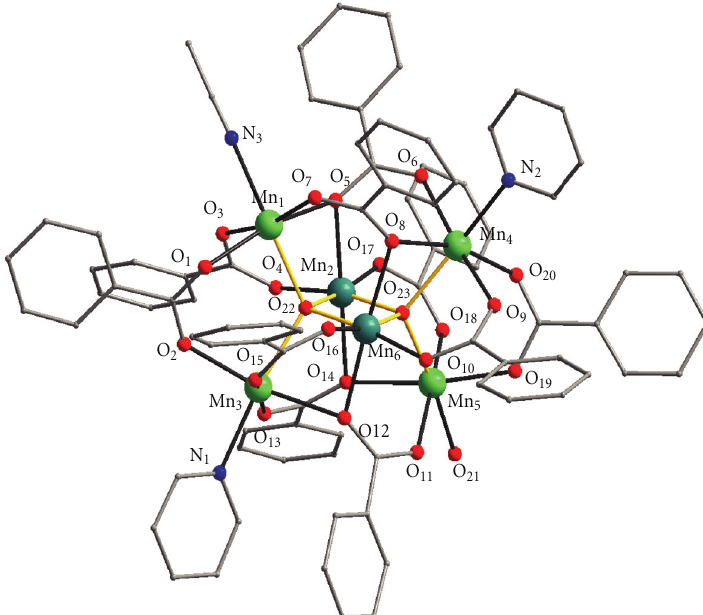
Figure 4: A partially labeled plot of 2 . The yellow lines emphasize the [Mn 4II Mn 2III ( μ 4 -O) 2 ] 10+ core. Color code: Mn II , green; Mn III , dark green; O, red; N, blue; C, grey. H atoms are omitted for